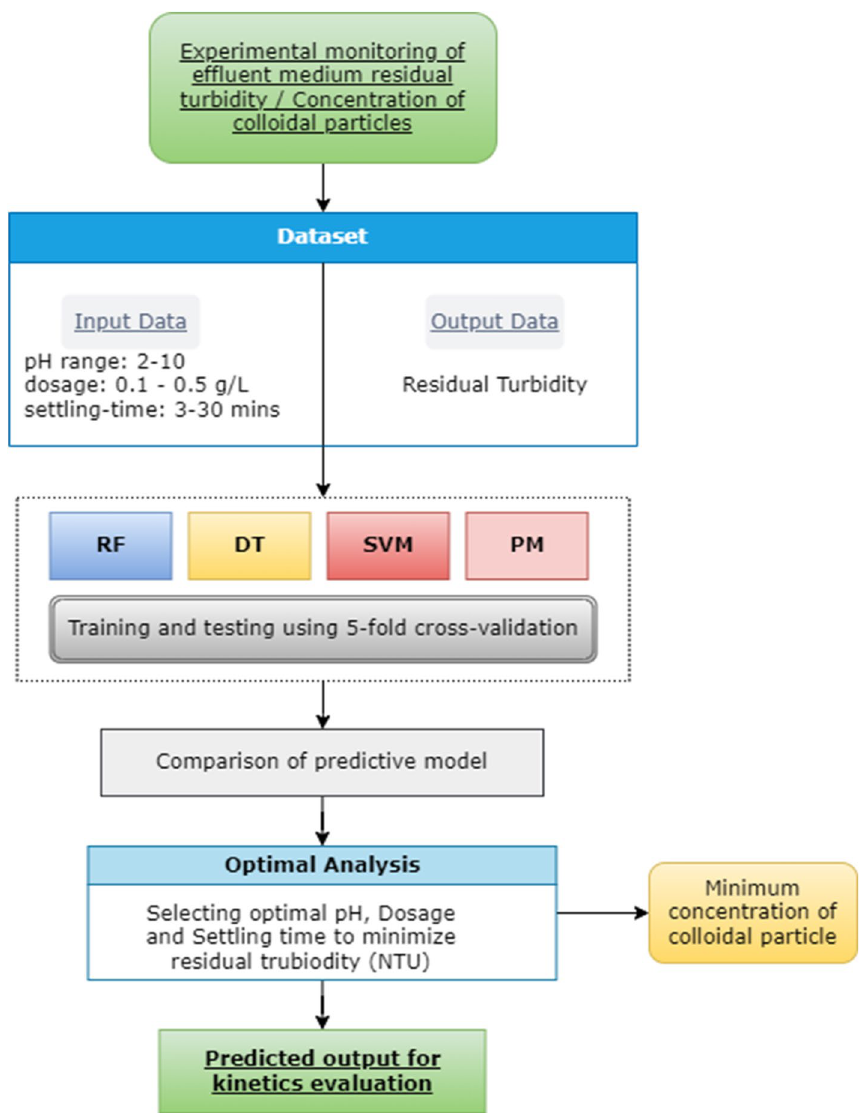
Fig. 1 Sequence of workflow for ML-driven optimization